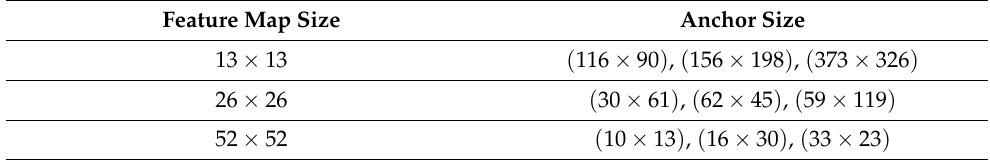
Table 1. Anchors for different feature maps.